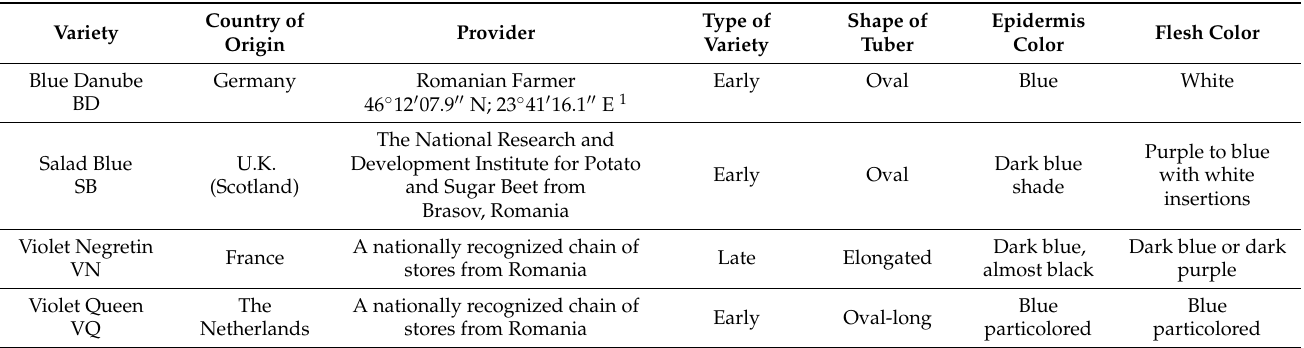
Table 1. Summary characterization of Solanum tuberosum L. varieties studied according to the Potato Variety Database [26].